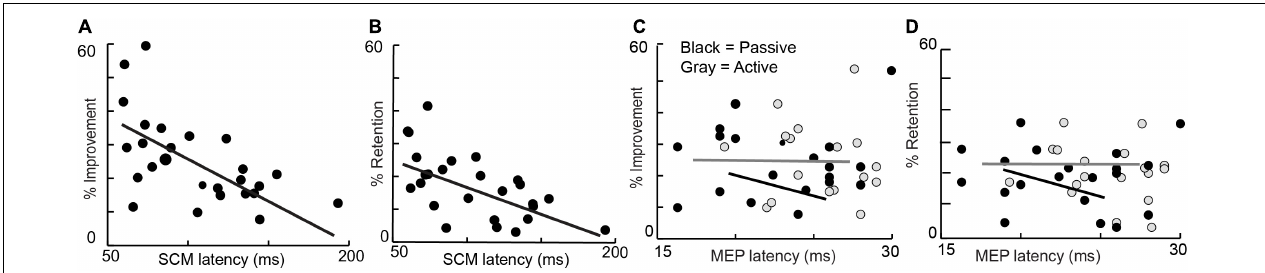
FIGURE 1 | Percent improvement (left) and Percent retention (right) are depicted against average startle (SCM) onset latency, active MEP Latency, and passive MEP onset latency of all subjects.